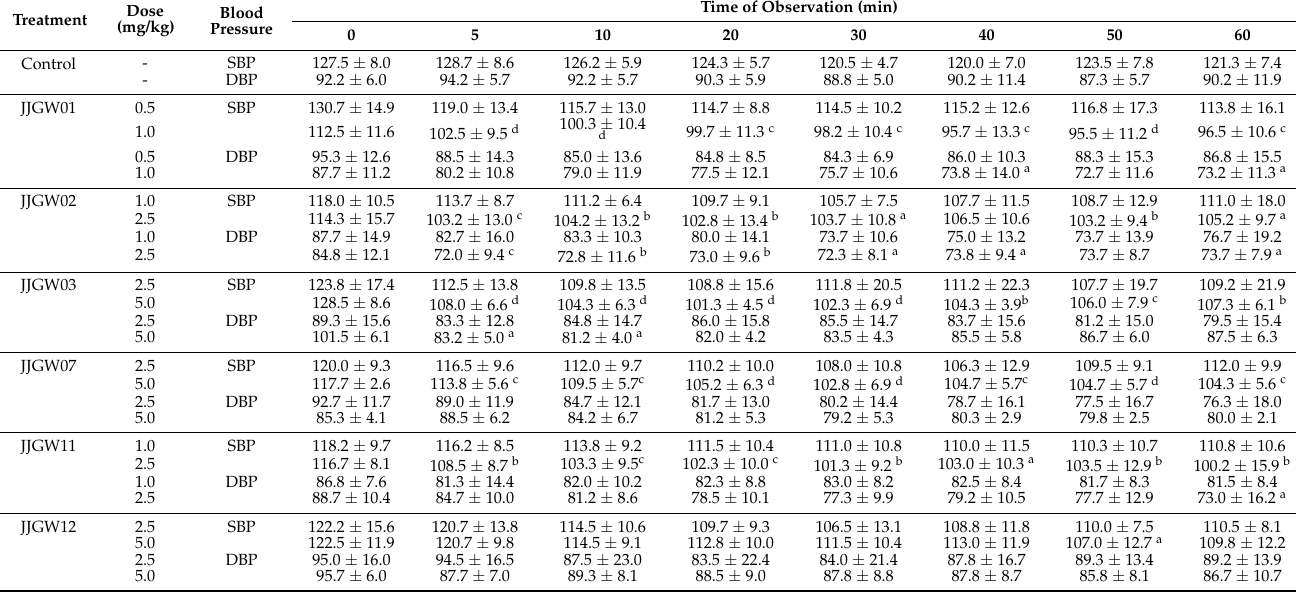
Table 6. The effect of arylpiperazine derivatives on the systolic and diastolic blood pressure in the normotensive